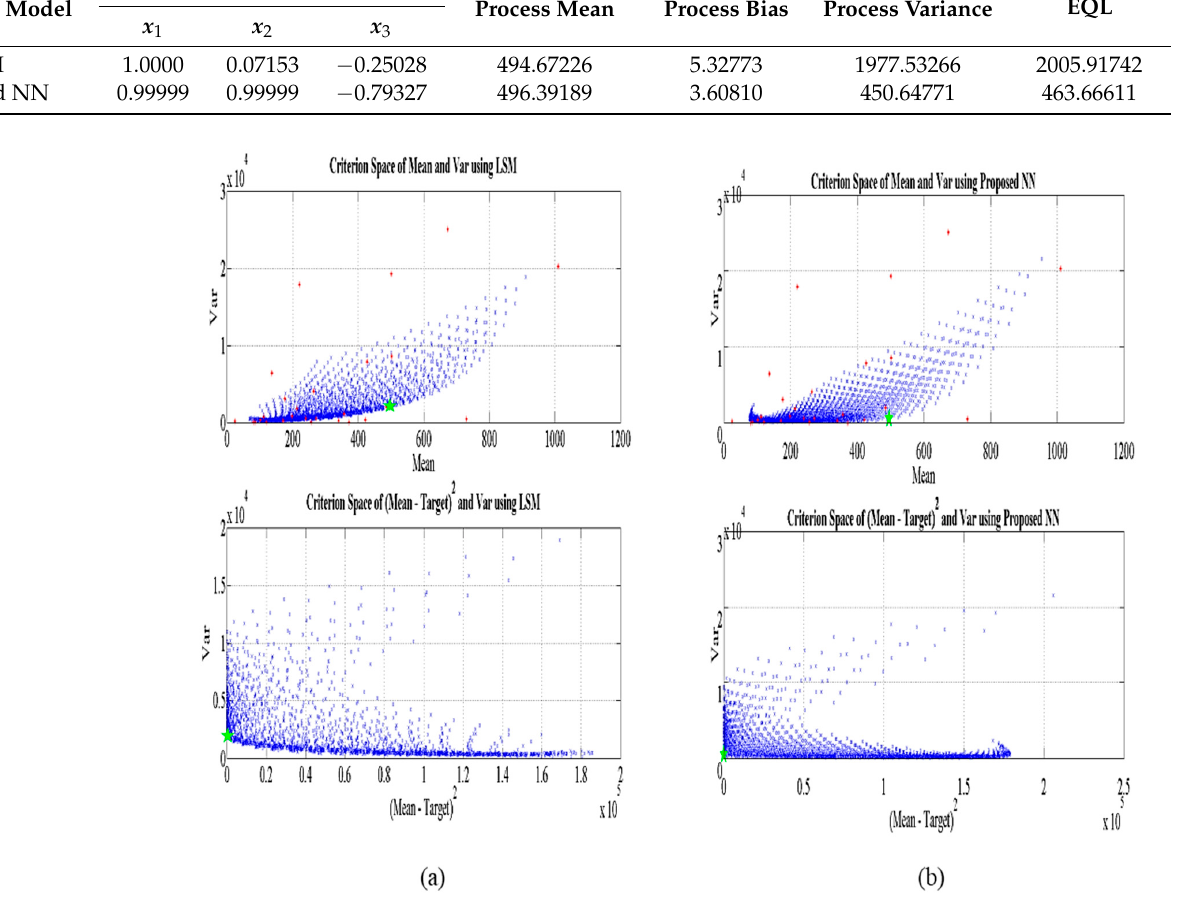
Figure 6. Criterion space of the two estimated functions: ( a ) conventional LSM; ( b ) proposed NN-based RD estimation model.